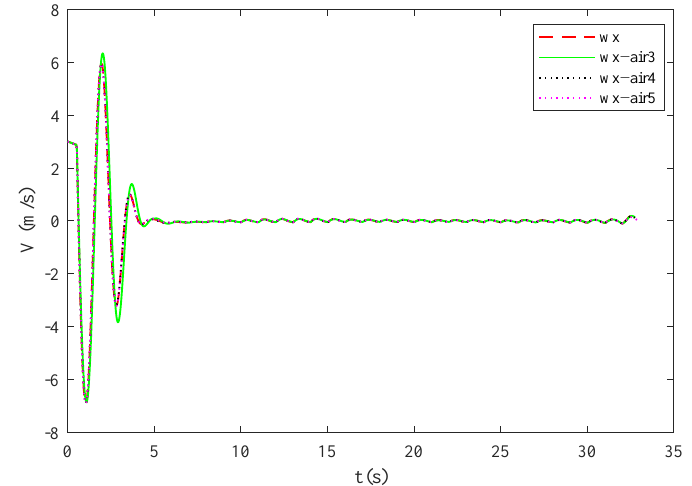
Figure 2. Change curve of roll angle rate under steerage deviation.